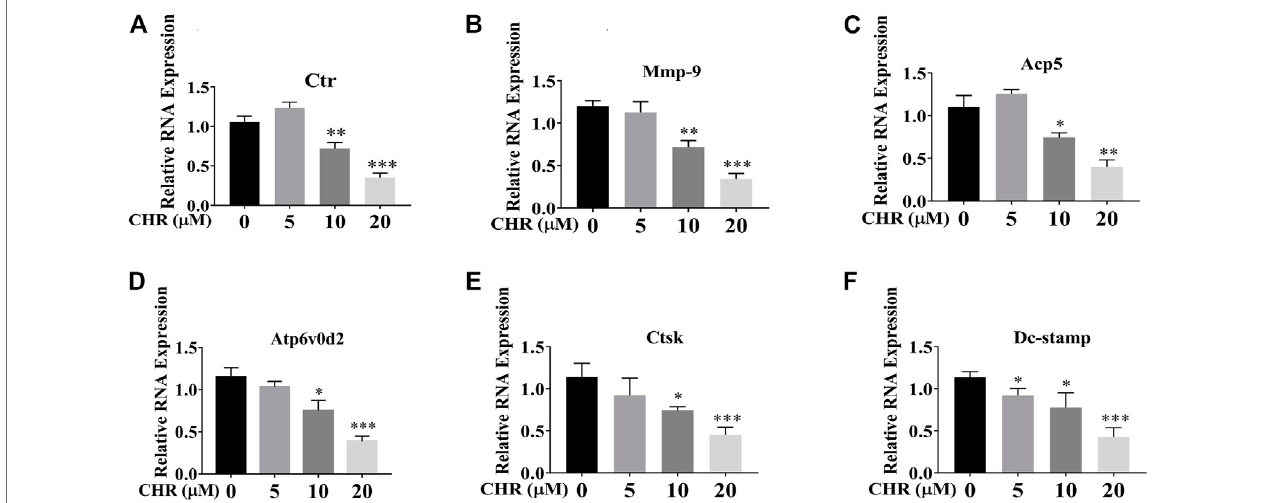
FIGURE2| CHRsuppressedRANKL-inducedexpressionofOC-associatedgenes.MurineBMMswerestimulatedwith30 ng/mlM-CSFand100 ng/mlRANKLin theabsenceorpresenceofindicatedconcentrationsofCHRfor6daystoformmultinucleatedTRAcPpositiveOCs.Cellwerelysed,RNAwereextracted,andthecDNA generated from reverse transcription were subjected to real-time quantitative PCR using speci fi c primers against OC-speci fi c genes. (A) Ctr, (B) Mmp-9 , (C) Acp5, (D) Atp6v0d2, (E) Ctsk, and (F) Dc-Stamp . Gene expression levels of Ctr, Mmp9, Acp5, Atp6v0d2, Ctsk, and Dc-stamp were expressed relative to control group (n =